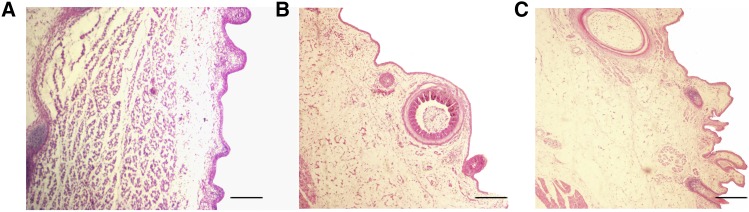
Microscopic observation of goose embryo skin at three different developmental stages. (A) primordial period of primary feather follicles at embryonic day 14; (B) primordial period of secondary feather follicles at embryonic day 18; (C) greater developmental period of secondary feather follicles at embryonic day 28. Magnified: 100×; Bar: 100 μm.